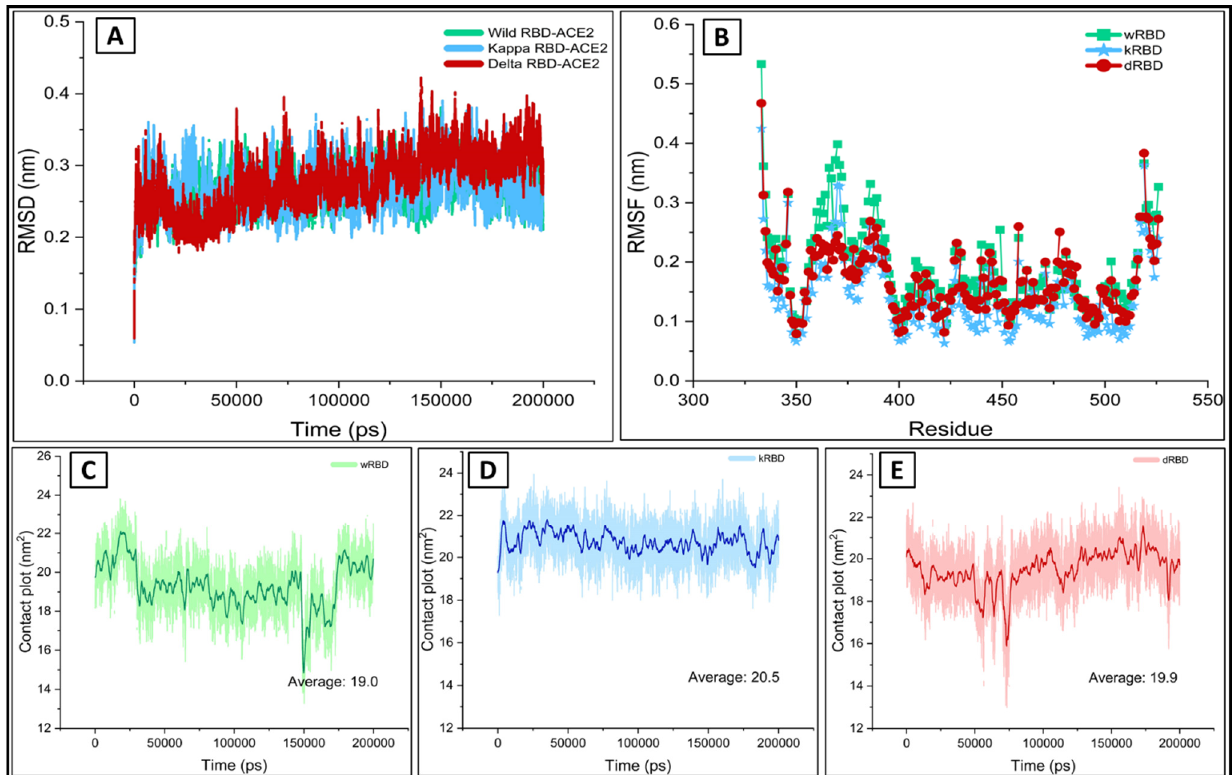
Figure 2. The molecular dynamics results of ACE2 in complex with the wild, kappa, and delta RBD during the 200 ns ( A ) The backbone RMSD of wtRBD (green), kRBD (blue), and dRBD (red) ( B ) The RMSF of wtRBD (green), kRBD (blue) and dRBD (red) in complex with the ACE2. The contact surface area of ( C ) wtRBD (green) ( D ) kRBD (blue), and ( E ) dRBD (red) structures of RBD bound to the ACE2.